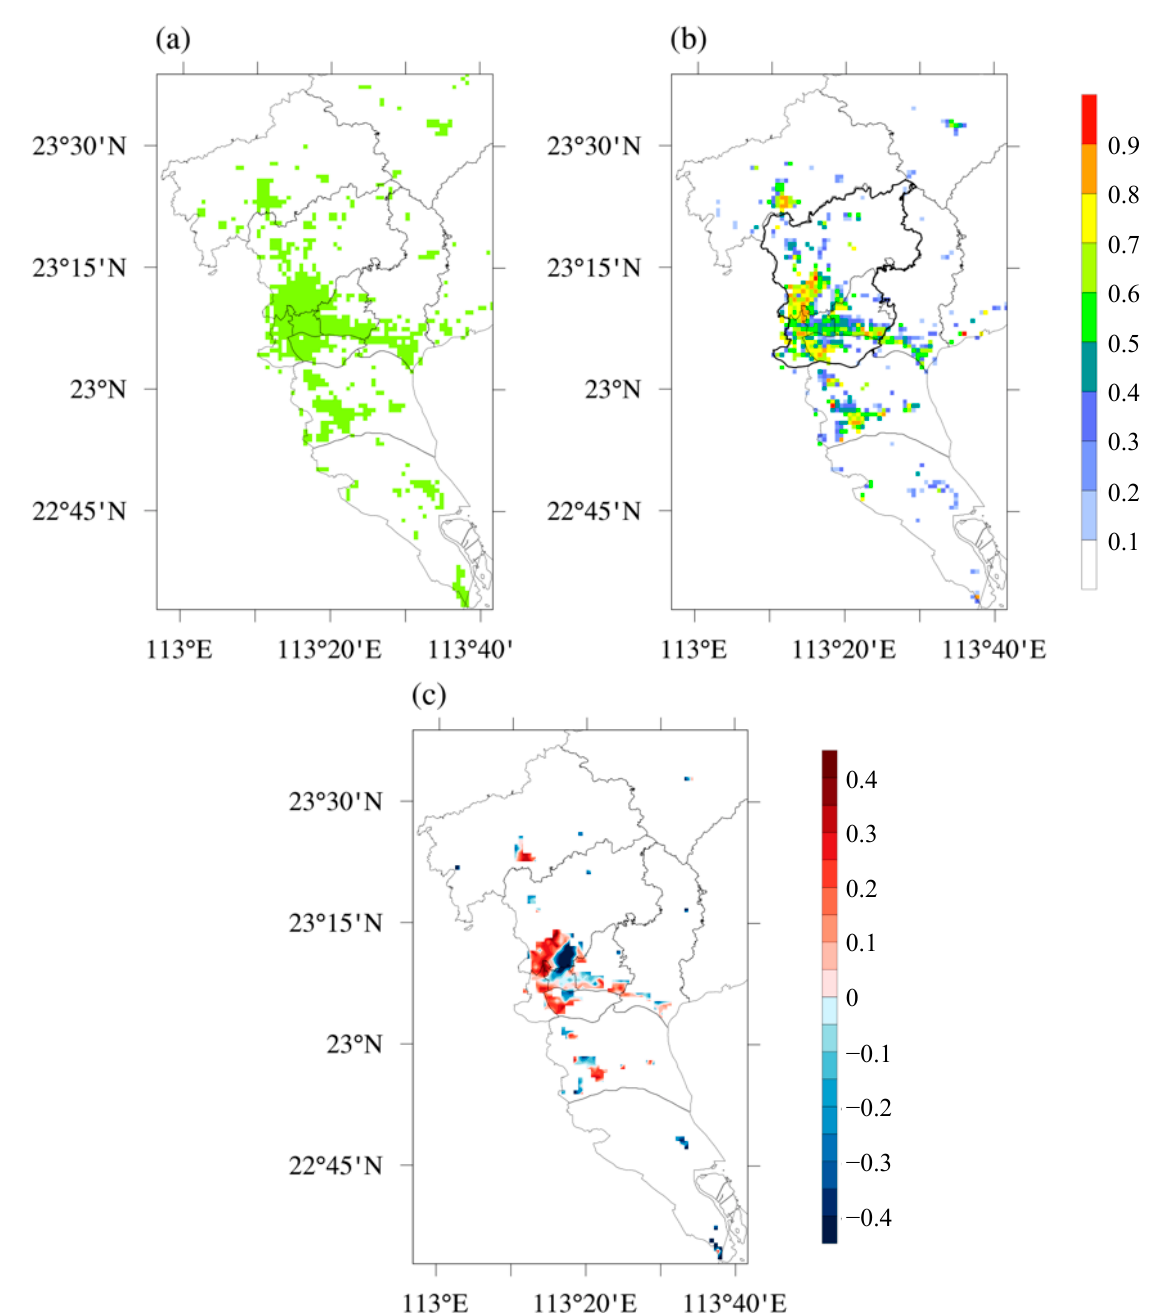
Figure 2. Diagrams showing the urban fraction (UF): ( a ) model default value, ( b ) localised value, and ( c ) difference between the localised and default values.